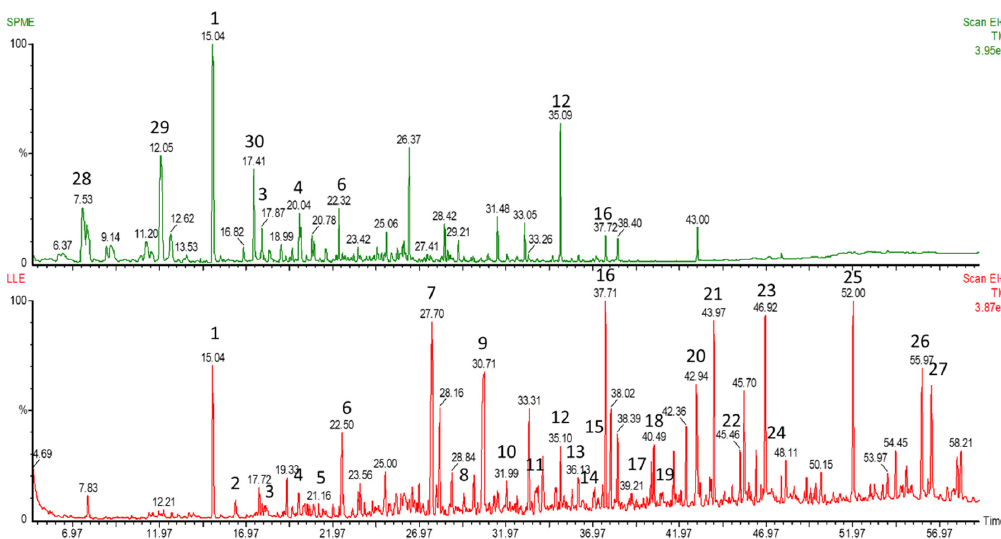
Figure 1. The comparison of total ion mass chromatograms of volatile compounds (VCs) extracted from urine sample using solid-phase microextraction (green chromatogram) and the optimized method (red chromatogram). The tentatively identified compounds: ( 1 ) Allyl isothiocyanate; ( 2 )